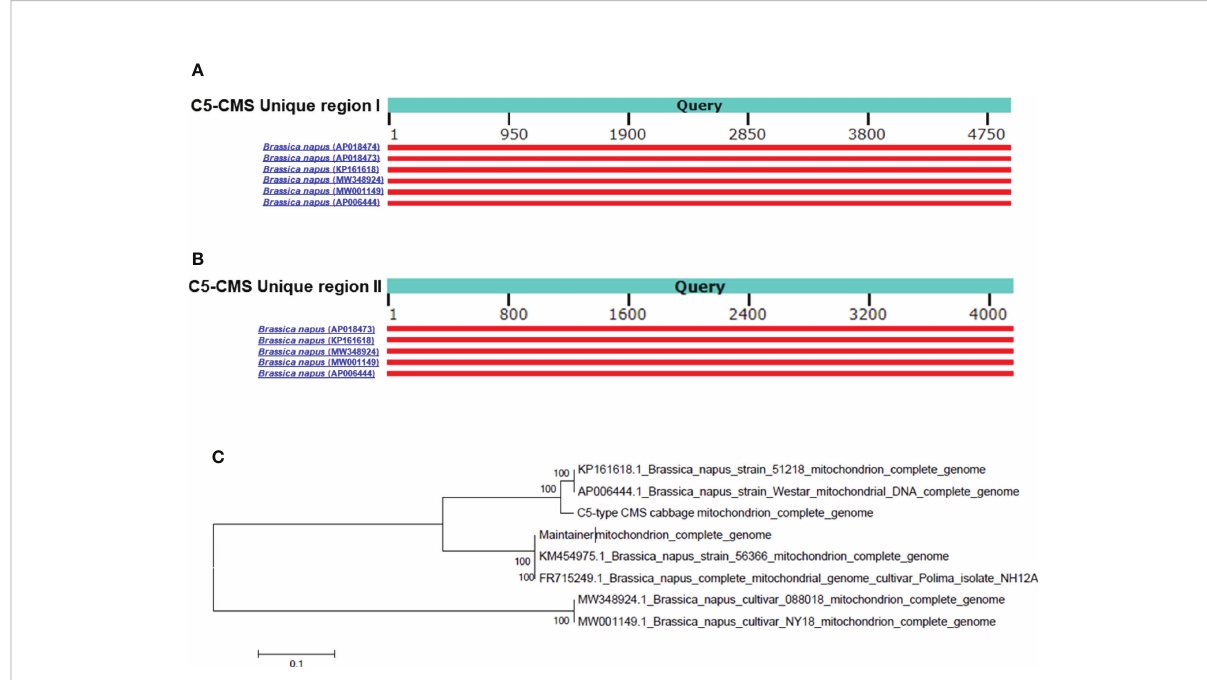
FIGURE 4 C5-CMS unique regions homologous to mitochondrial genomes and phylogenetic analysis based on the mitochondrial genome. Alignment of the C5-CMS unique region I (A) and C5-CMS unique region II (B) to the mitochondrial genomes of the B. napus lines (AP018474, AP018473, KP161618, MW348924, MW001149, and AP006444). The query sequences were C5-CMS unique region I (4897 bp) and unique region II (4141 bp). Red-colored boxes indicate the scores of sequence alignment with the mitochondrial genomes. (C) Phylogenetic tree constructed using C5-type CMS mitochondrial sequence and seven complete mitochondrial genome sequences of B. napus lines (AP018474, AP018473, KP161618, MW348924, MW001149, KM454975 and AP006444). The unrooted phylogenetic tree was created in MEGA 6.0 software by the ML method with 500 bootstrap